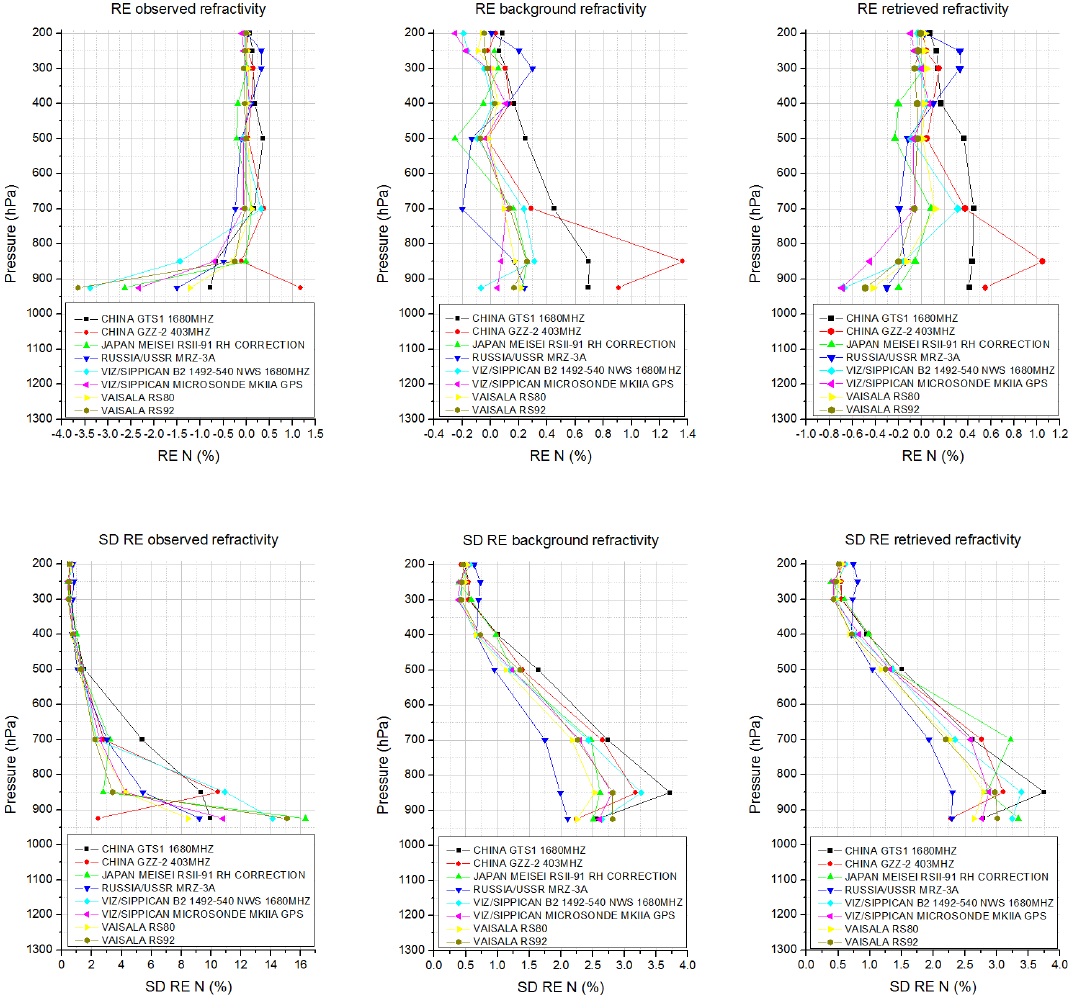
Fig. 10. Relative error and SD between the refractivity of different radiosonde types and the refractivity from the 1DVAR product wetPrf, radio occultation observation, and background,